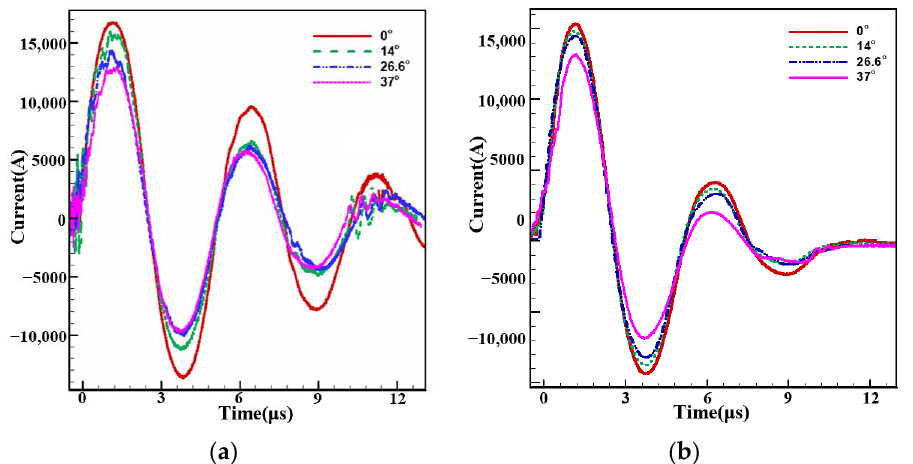
Figure 8. The rectangular electrode APPT discharges current waveforms at various flare angles: ( a ) the electrode spacing is 3 mm and ( b ) the electrode spacing is 25 mm. Table 1. T he APPT discharge circuit parameters with the rectangular electrode with different flare angles.